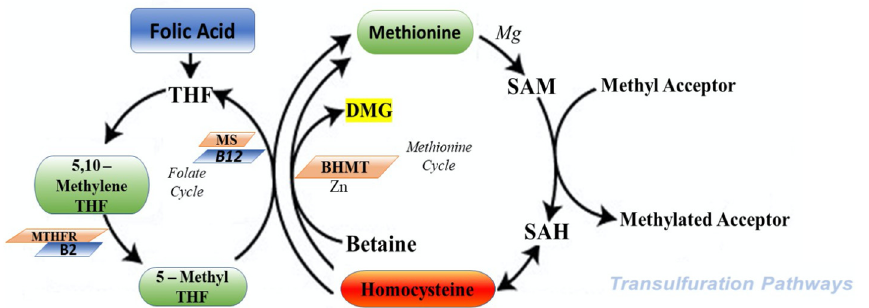
Figure 2. Transsulfuration cycle. The metabolism of HCY (homocysteine) is composed by two